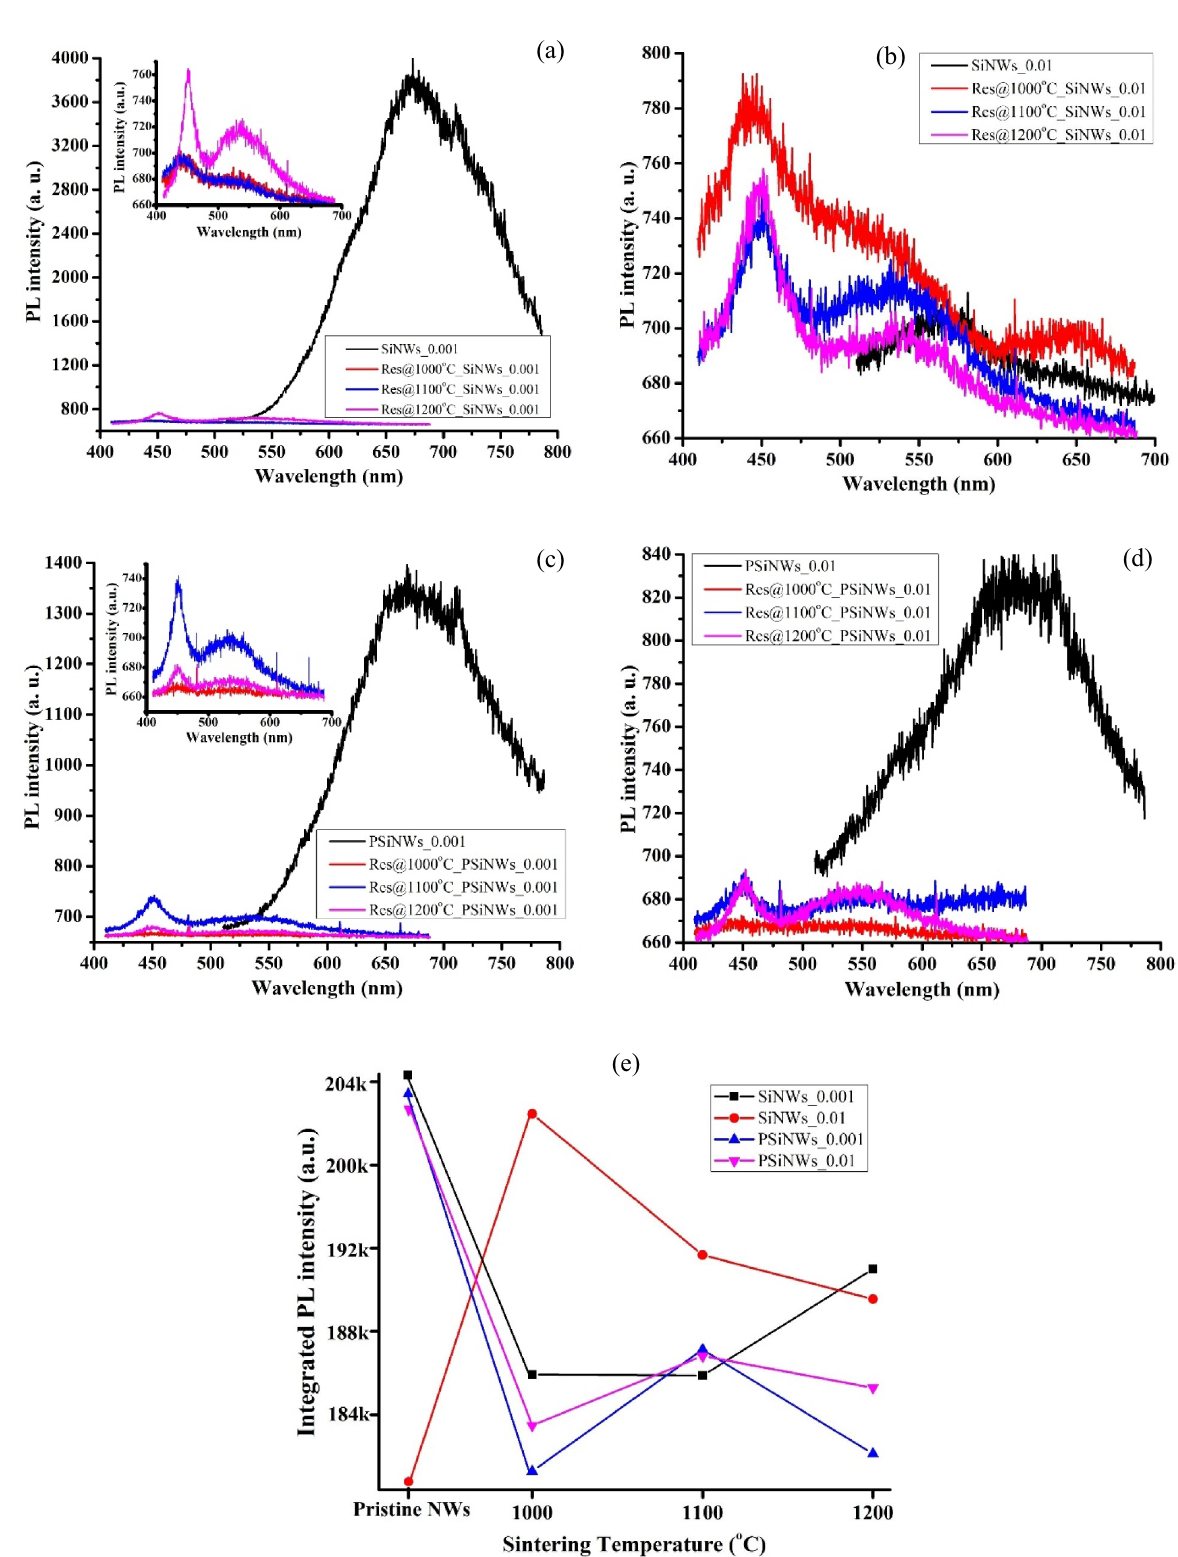
Figure 6. PL spectra of pristine and sintered NWs for ( a ) SiNWs_0.001, ( b ) SiNWs_0.01, ( c ) PSiNWs_0.001, ( d ) PSiNWs_0.01 sample. ( e ) integrated PL spectra of reference (i.e., pristine) and sintered